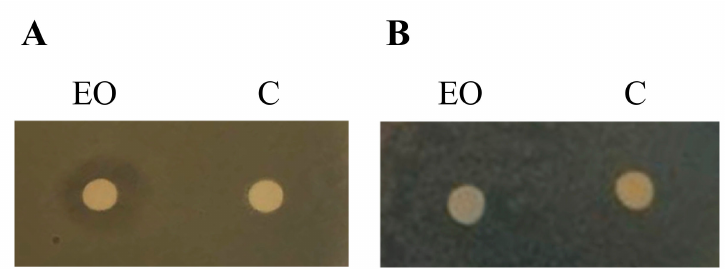
Figure 4. Antibacterial activity of the essential oil (EO) against S. aureus ATCC25923 ( A ) and E. coli K12 ( B ). The presence of the halo around the disk, previously soaked with the EO, demonstrates the antibacterial activity against S. aureus ATCC25923. C: Negative control.